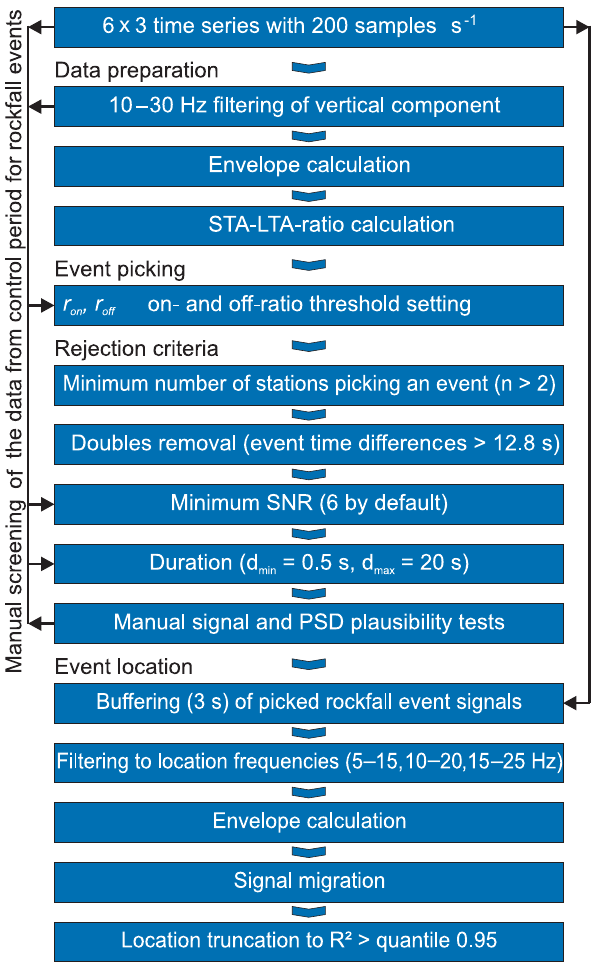
Figure 3. Schematic flow chart of the work flow for seismic data analysis. Arrows along left side of the boxes indicate utilisation of control period